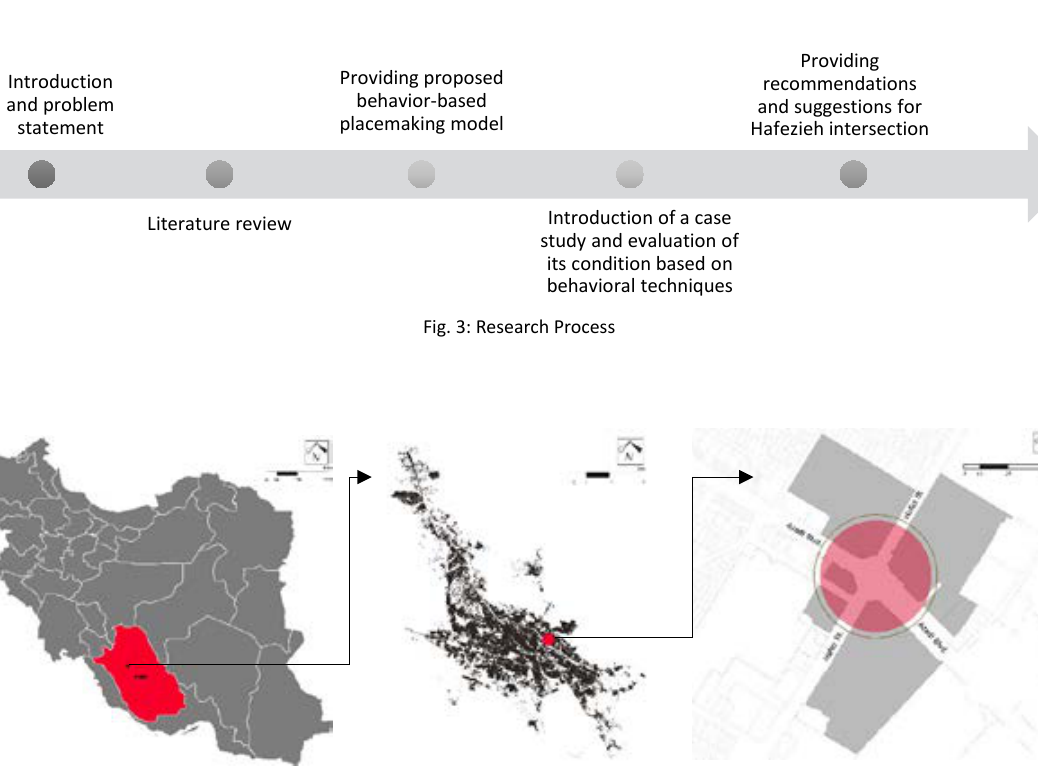
Fig. 4: Hafeziyeh intersection location within Shiraz; source: authors: a) Iran map, b) Shiraz city in Fars, Iran and c) Case study location